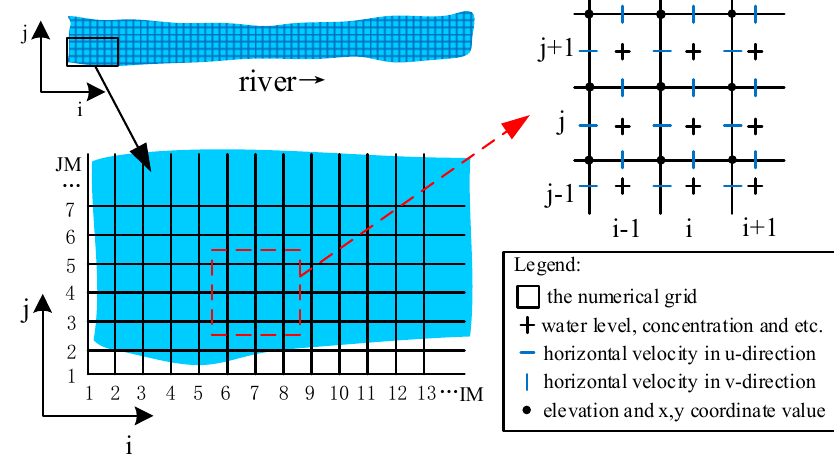
Figure 1. Structured grids identification and calculation in grids.